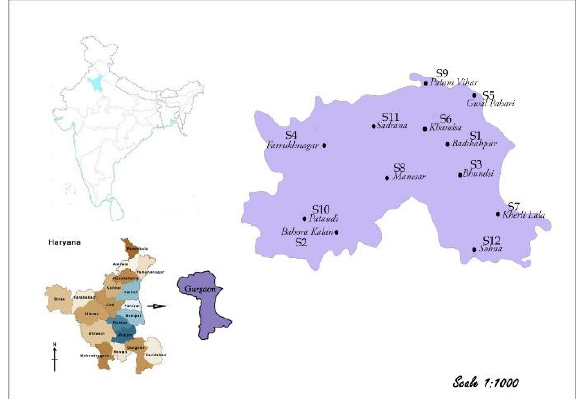
Figure 1. Map of Gurugram and the